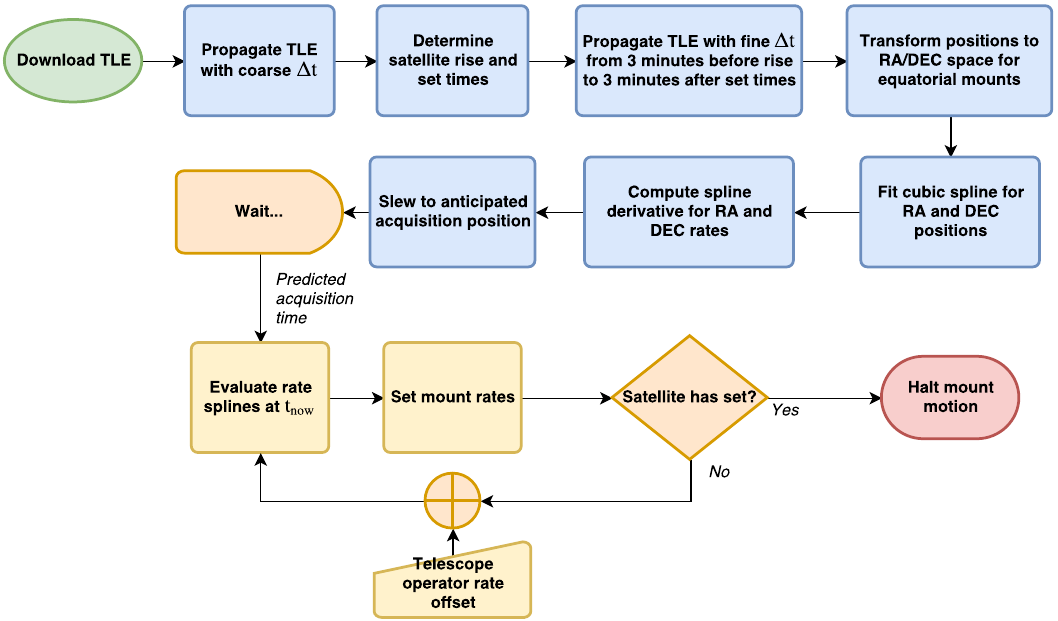
Figure 5. An open/human-in-the-loop algorithm for satellite tracking by two-line element set